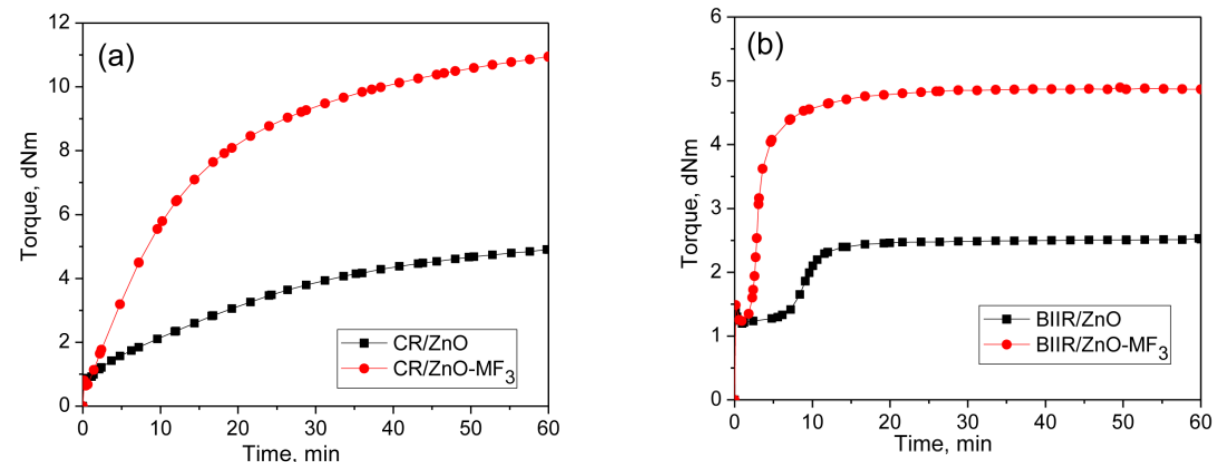
Figure 3. Curing curves of ( a ) Mixes 3 and 4 ( b ) mixes 5 and 6 at 170 °C for 1